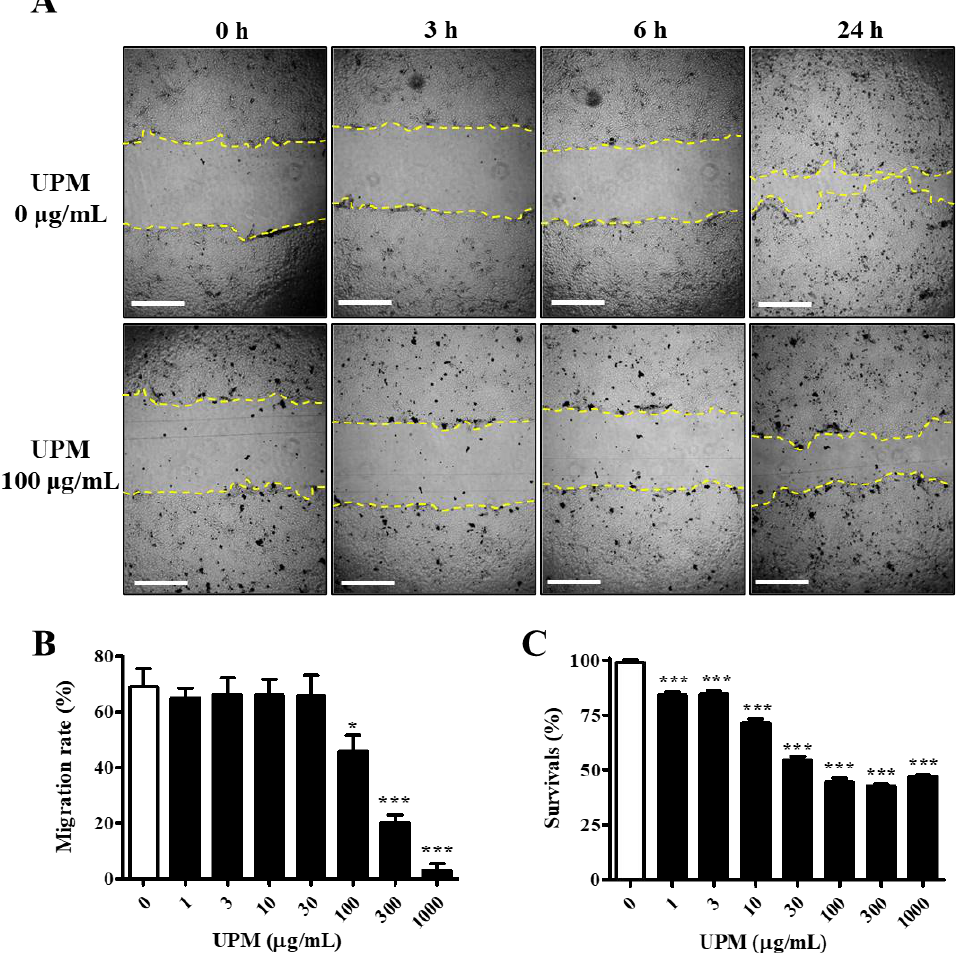
Figure 1. Effect of UPM on the migration activities of human corneal epithelial (HCE) cells. ( A ) HCE cells treated with UPM at various concentrations for 24 h were scratched, and the empty area (yellow lines) was measured. Each area was measured after scratching at 3, 6 and 24 h. The scale bars indicate 100 μm. ( B ) The relative migration rate of HCE cells at 24 h is expressed as the mean ± SD. ( C ) The survival rate of HCE cells treated with UPM at various concentrations for 24 h is expressed as the mean ± SD. * p < 0.05, *** p < 0.001 compared with 0 μg/mL UPM.